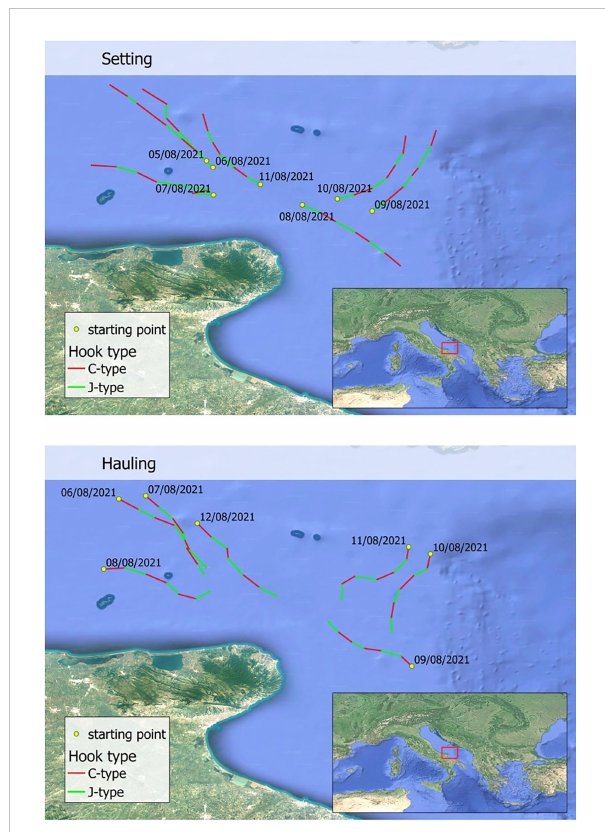
FIGURE 1 Setting and hauling of the longline with J-type hooks (green) and C-